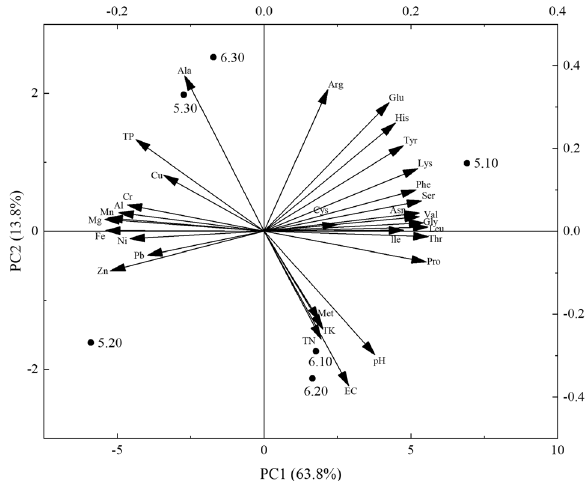
Figure 5. Principal component analysis of each factor in earthworm mucus induced by different electrical stimuli. 5.10, 5.20, 5.30, 6.10, 6.20, 6.30 indicate 5 V 10 mA, 5 V 20 mA, 5 V 30 mA, 6 V 10 mA, 6 V 20 mA, and